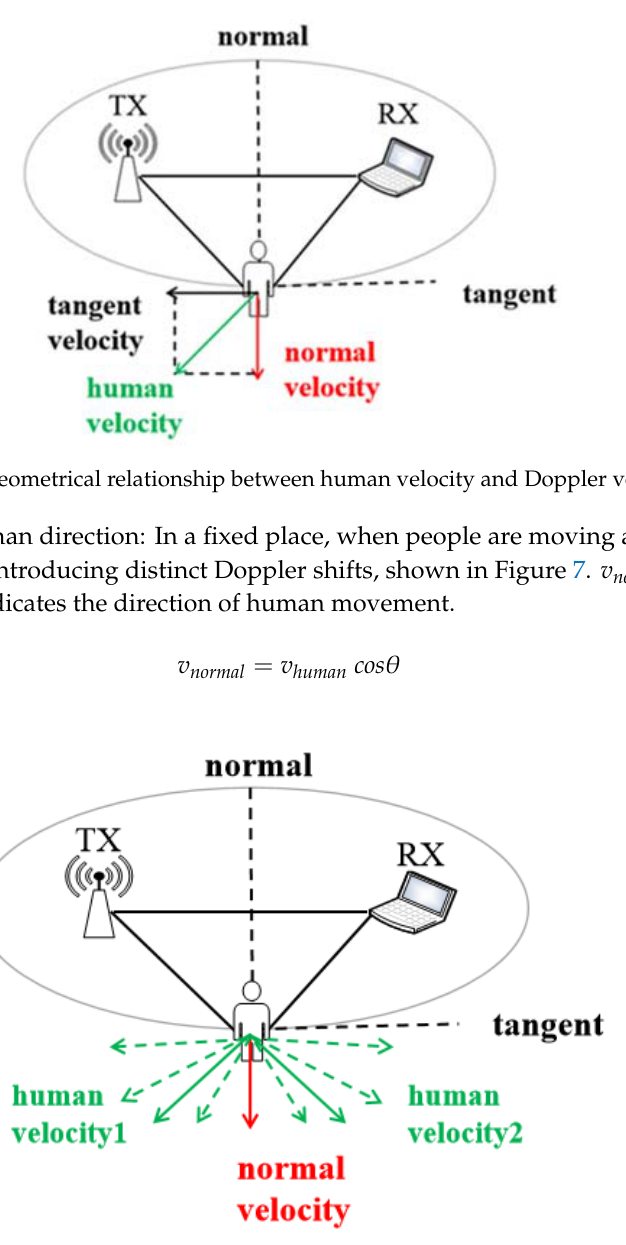
Figure 6. Geometrical relationship between human velocity and Doppler velocity.